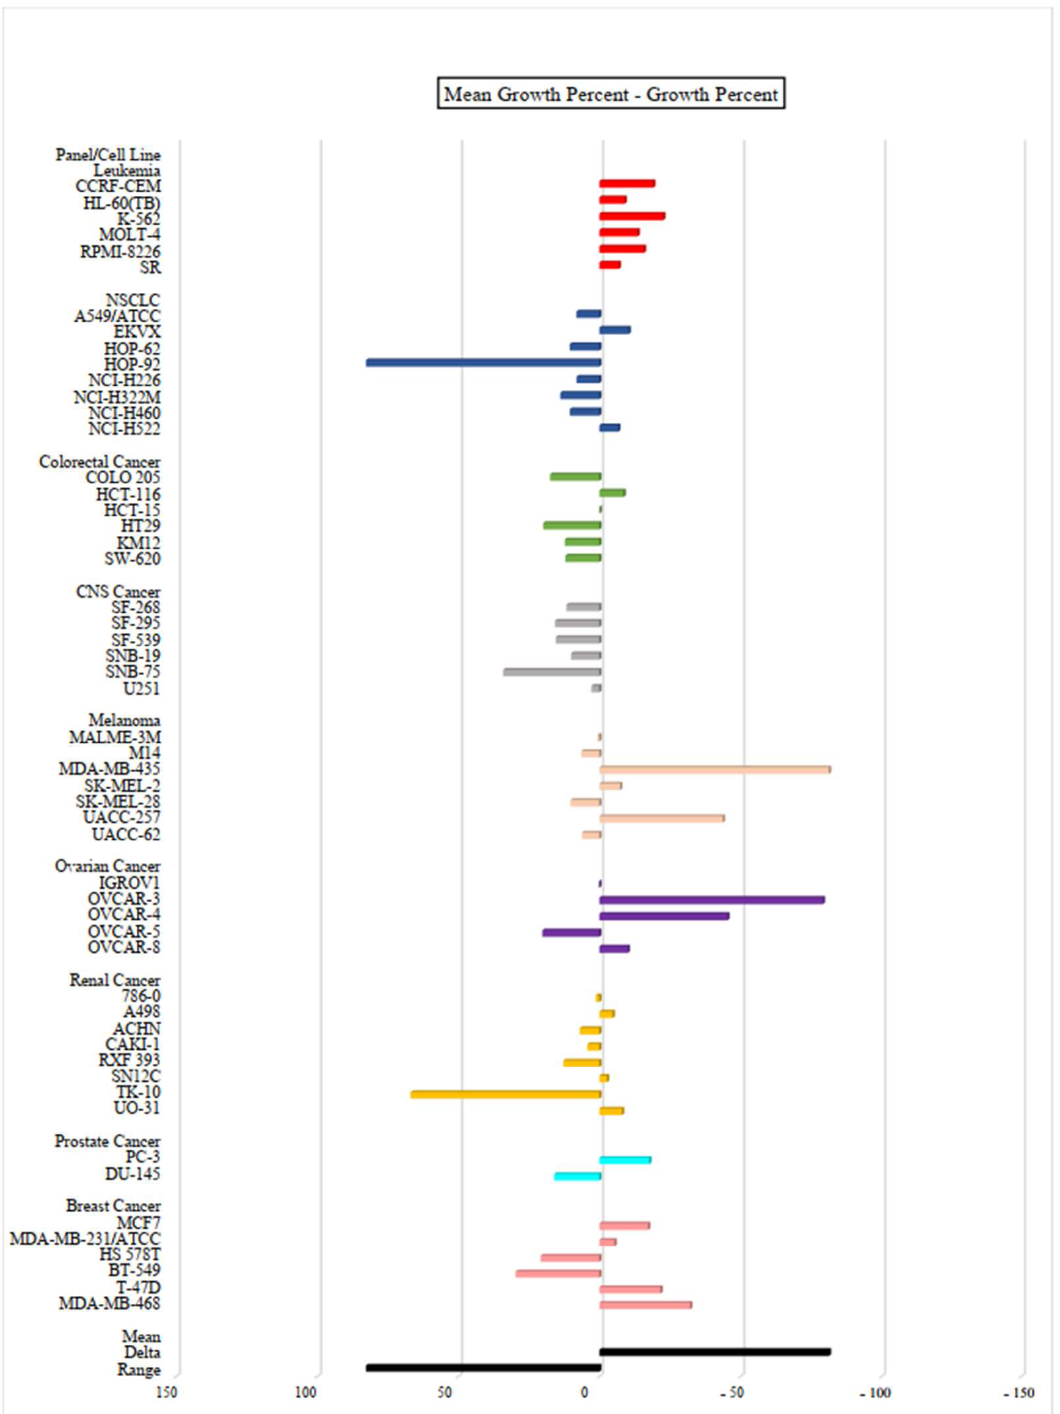
Figure 6. One-dose (10 μM) mean graph of PQ3 against different cancer cell lines. All experiments were repeated one time.